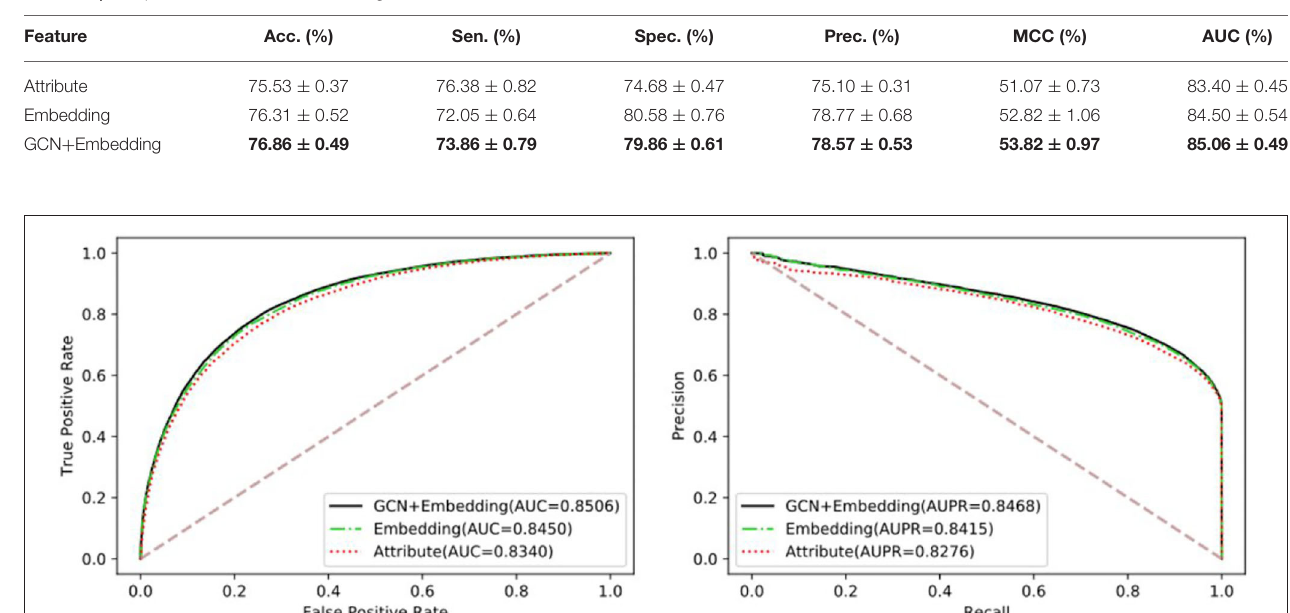
Frontiers in Genetics |